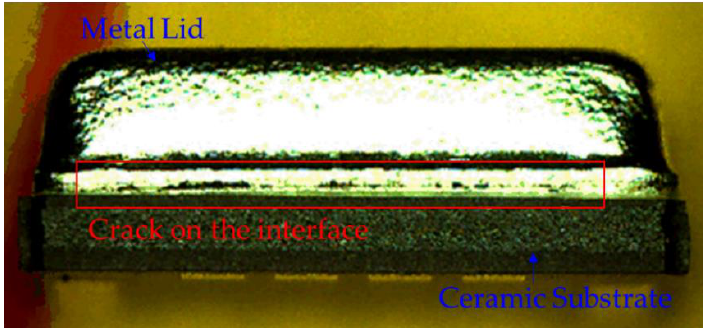
Figure 2. The crack occurred between the metal lid and the silver epoxy in the hermetic MEMS package.